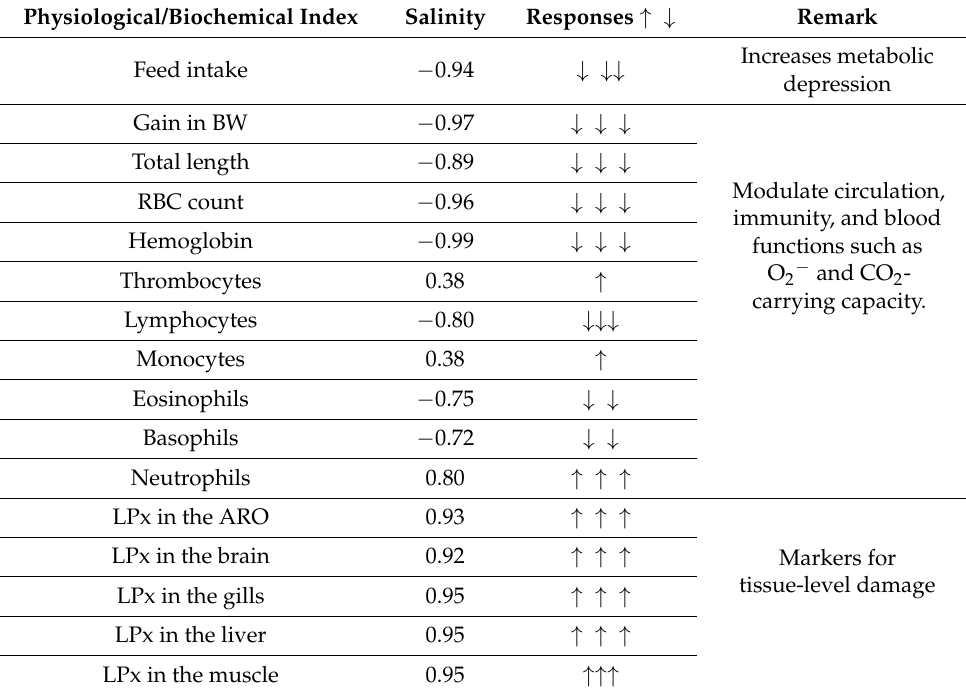
Table 1. Low-salinity-modulated physiological responses (oxidative stress) in freshwater